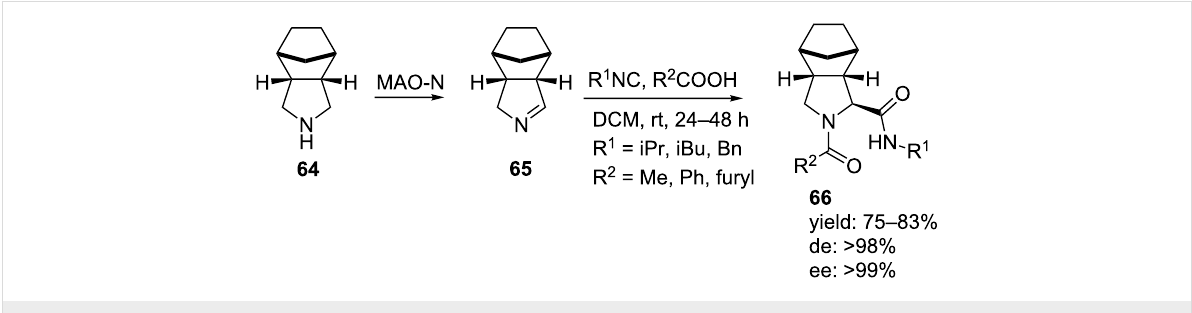
Scheme 20: Enantioselective MAO-U-3CR procedure starting from chiral pyrroline 64